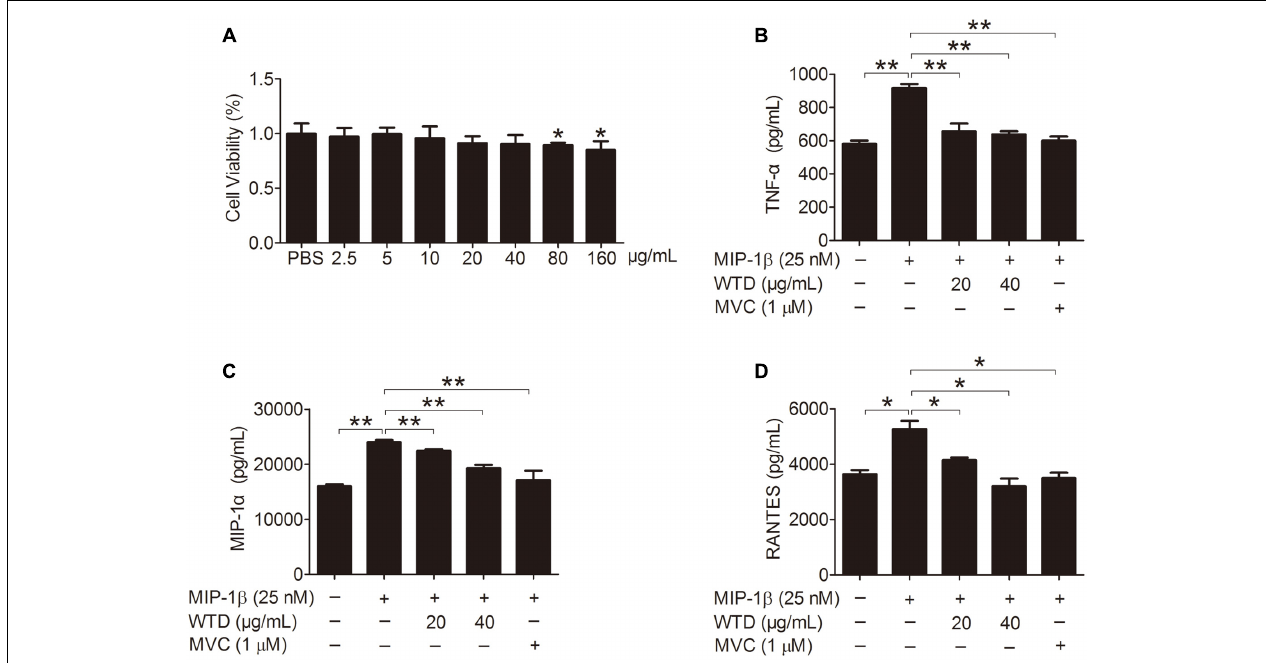
FIGURE 2 | Inhibition of MIP-1 β -induced production of TNF- α , MIP-1 α , and RANTES by WTD in U937 cells. (A) Effect of WTD on cell viability of U937. U937 cells (1 × 10 4 cells/well in a 96-well plate) were pretreated with different concentrations of WTD for 45 h, followed by incubation with 10 µ L CCK8 for 3 h. And then OD values were measured at 450nm. ∗ P < 0.05 vs. PBS group. (B–D) Inhibition the production of TNF- α , MIP-1 α , and RANTES in MIP-1 β -induced U937 cells by WTD. PMA-induced U937 cells were pretreated with or without WTD, followed by exposure to MIP-1 β (25 nM) for 24 h. The cell supernatants were collected to detect the levels of TNF- α , MIP-1 α , and RANTES by ELISA. Data were expressed as mean ± SD. ∗ P < 0.05, ∗∗ P < 0.01.